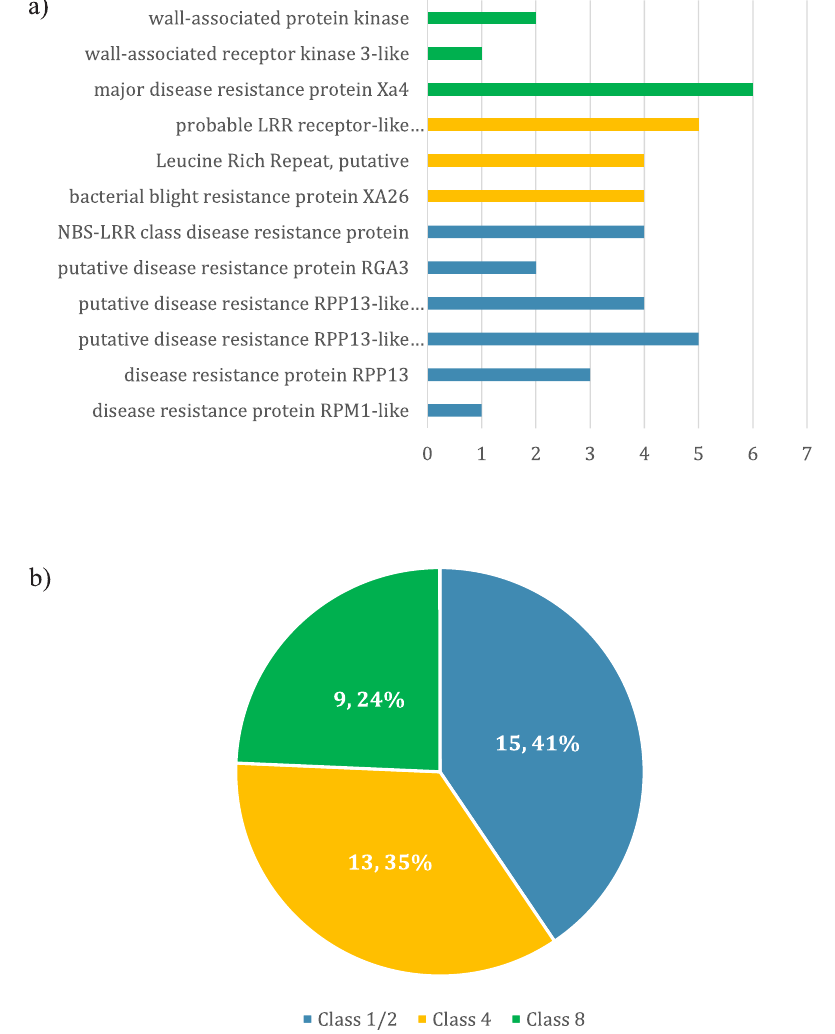
Fig. 1. The breakdown of R-genes in qBBR11-1 a) the number of -genes for each description b) the distribution of R-genes according to different R-genes